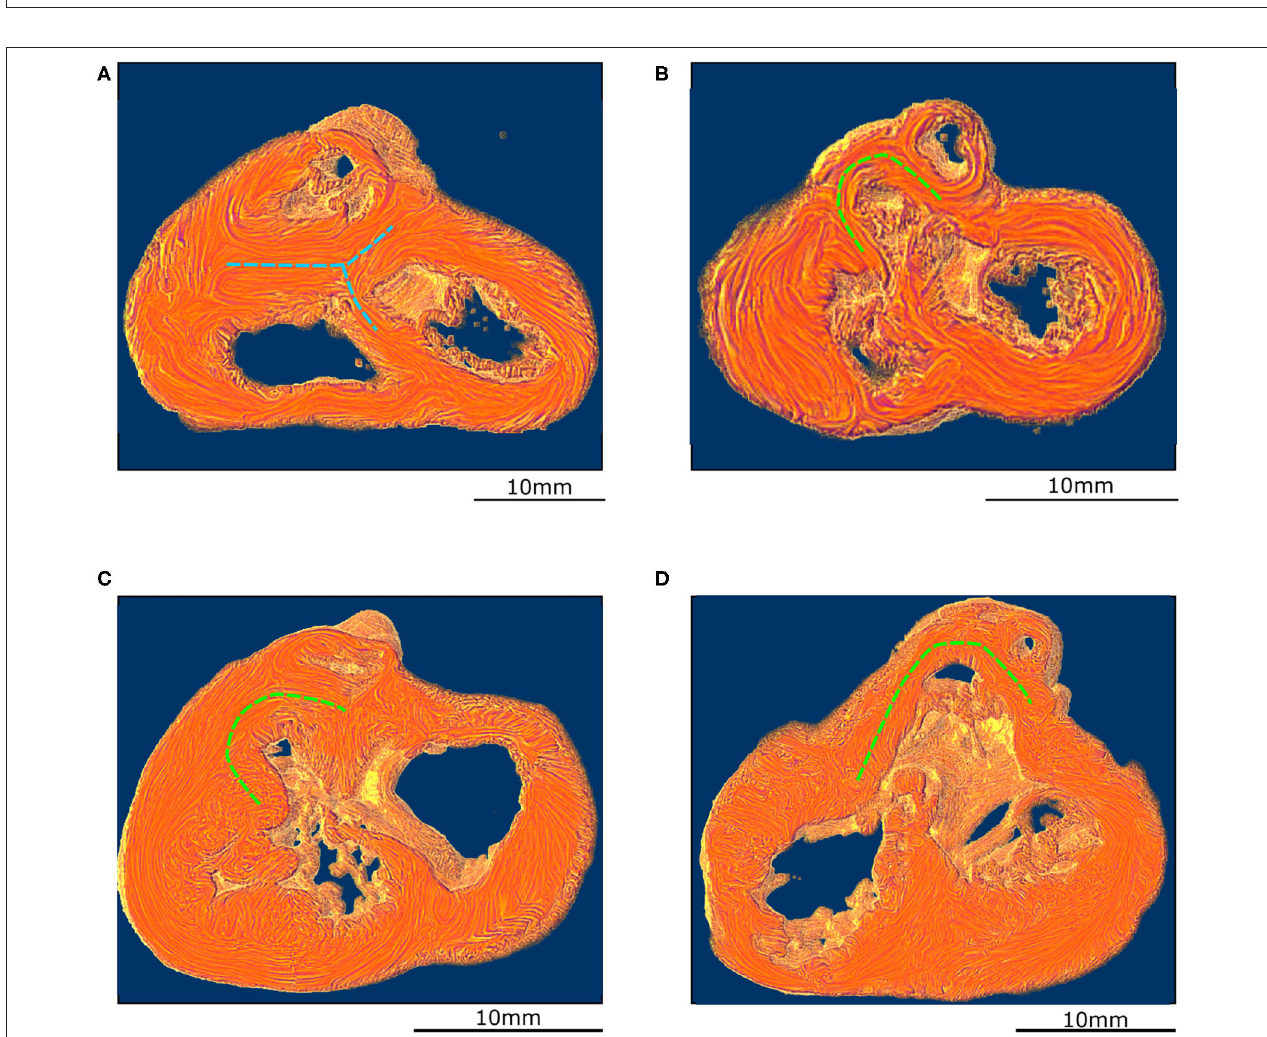
FIGURE 4 | Virtual dissection of the ventricular mass to highlight the variability of the VIF. (A) Control heart–normal pattern, (blue dashed lines), (B) regular ToF, (C) ToF with severe hypoplasia of the outflow tract and (D) ToF with atretic pulmonary valve. The protrusion of the VIF in the right ventricular cavity is also variable. These three structures: the VIF, the RVW, and the OS define a muscular arch overriding the interventricular communication and the outflow tract of the left ventricle as an “inverted U,” well-seen in the short axis section (D,B) . This “inverted U” muscular arch (green dashed lines) is present in all observed ToF of this study, irrespective of the size of the different constitutive parts of the